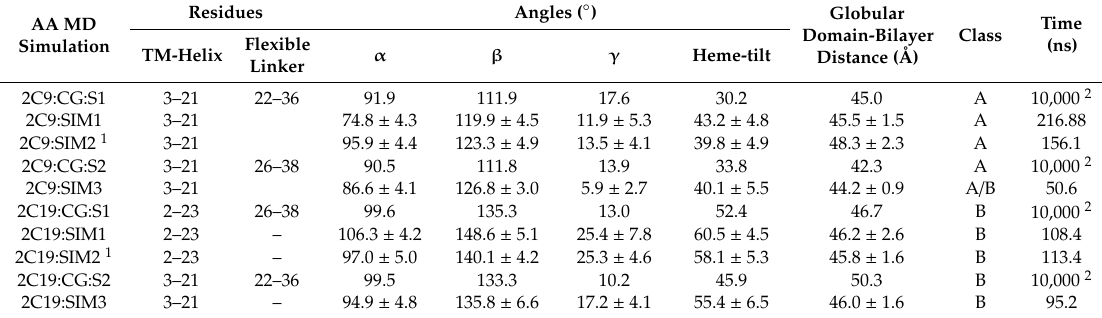
Table 2. Positioning of the CYP globular domain with respect to the membrane in the AA MD simulations of CYP 2C9 and CYP 2C19. Values of the mean and standard deviations of angles (as defined in Figure 2) and distances characterizing the positioning of the globular and TM domains were calculated for the last 50 ns of all-atom simulations, with di ff erent starting configurations from CG simulations and with di ff erent initial velocities assigned. The orientations of the globular domain were assigned to class A, A / B, or